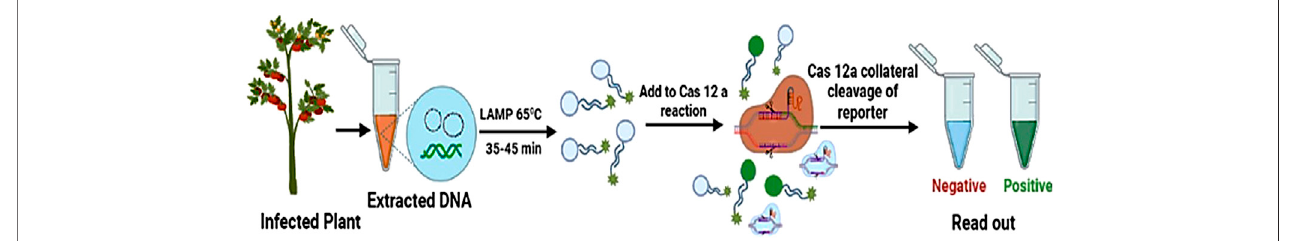
FIGURE5 | LAMP-coupled Cas12-based assay forthe detection ofplant viruses. Viral DNA extracted from an infected tomato plant isampli fi edby loop-mediated isothermal ampli fi cation (LAMP), followed by CRISPR-mediated detection. Cas12a-based detection of the LAMP product triggers collateral cleavage of the reporter, thus producing a signal for visual